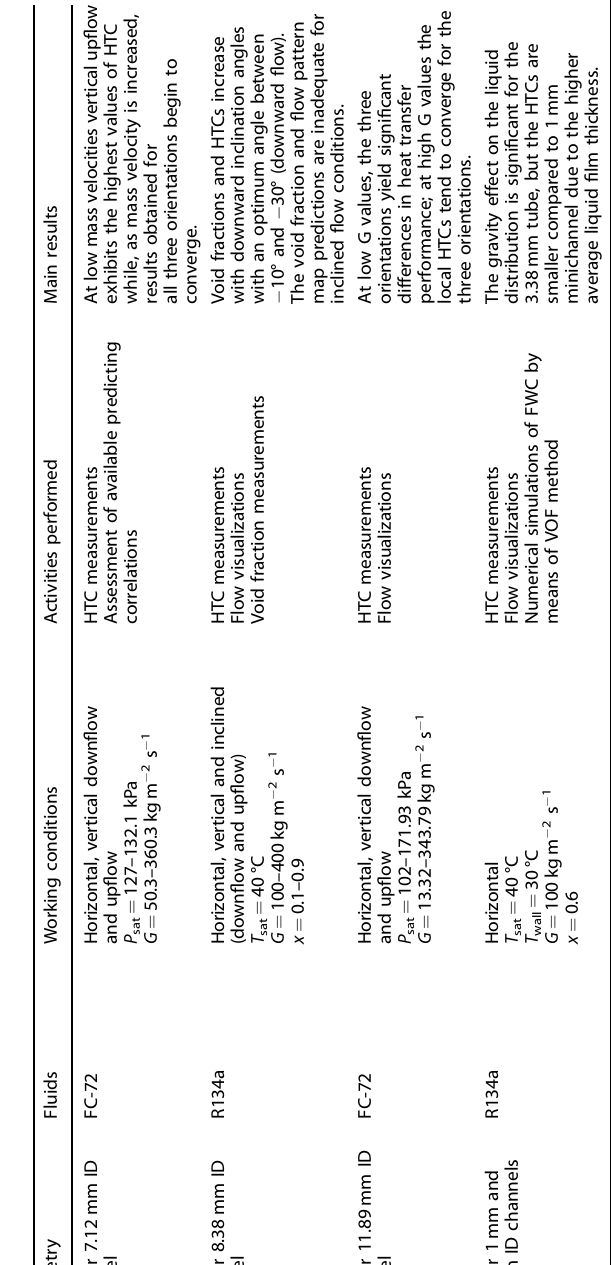
discussed in the following sub-sections. In Tables 1 and 2, T sat is the saturation temperature, P sat is the saturation pressure, T wall is the wall temperature, Δ T sat-wall is the saturation-to-wall tempera- ture difference, G is the mass velocity, ṁ f is the mass fl ow rate, Re G is the Reynolds number of the gas phase, calculated using Eq. (1), while x is the mean/local vapor